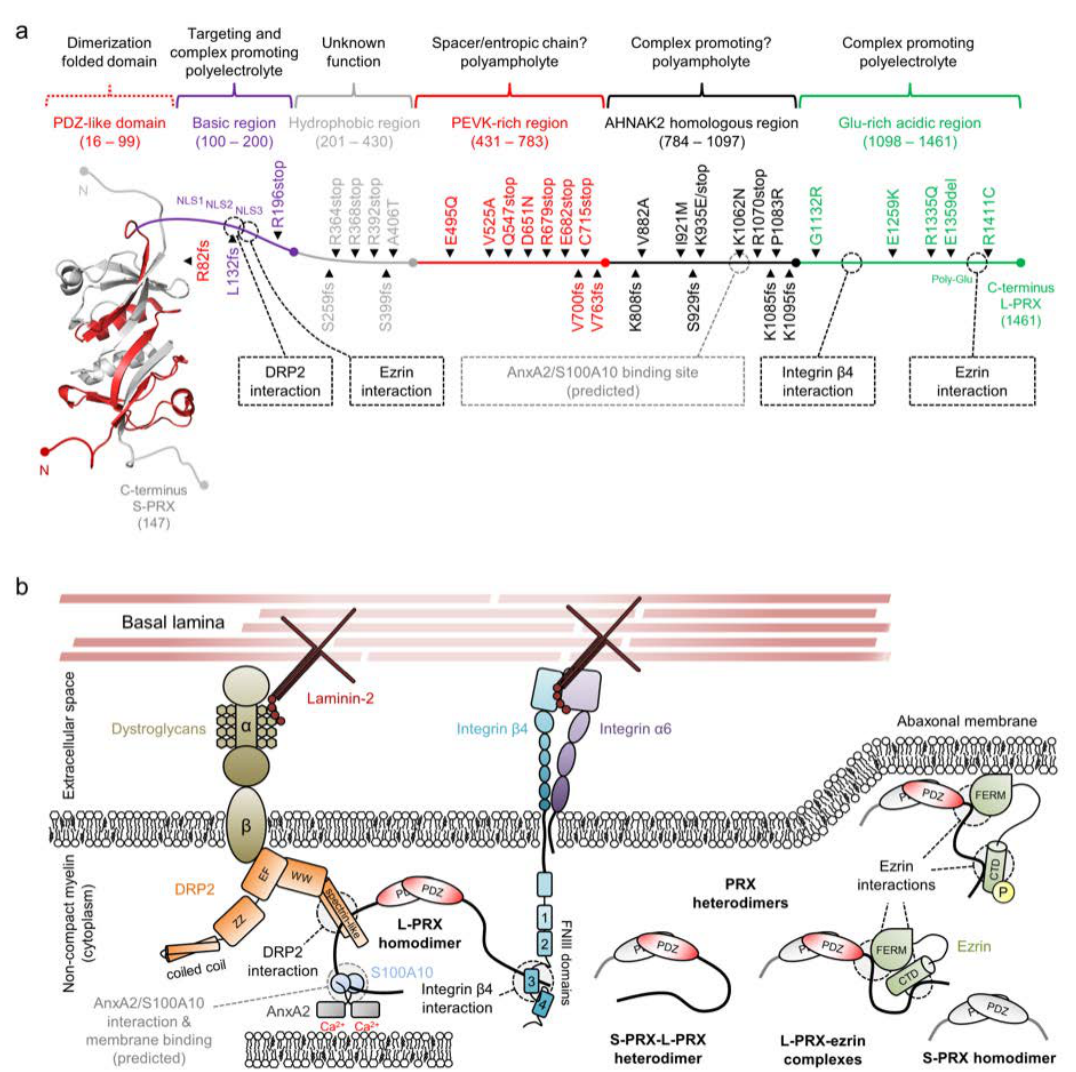
Figure 8. The structure and interactions of periaxin. ( a ) A schematic of a PRX heterodimer, with S-PRX in gray and L-PRX colored based on region, with the PDZ domain in red. L-PRX, apart from the PDZ-like domain, is predicted to be disordered [45], and can be divided into separate regions based on sequence composition. Peripheral neuropathy mutations are indicated alongside L-PRX. Dashed boxes and lines denote protein–protein interactions. L-PRX contains a predicted AnxA2 and S100A10 binding region, as reported earlier for AHNAK [195,196]. See Table 1 for mutation details. ( b ) L-PRX is an assembler within abaxonal non-compact myelin, linking dystroglycans and integrins together in membrane appositions, forming the periaxinosome. These interaction partners connect the Schwann cell basal lamina to the Schwann cell cytoplasm. S-PRX forms heterodimers with L-PRX, which might allow regulation of the cytoplasmic assembly as well as the nuclear export of L-PRX. Ezrin in complex with hetero- or homodimeric L-PRX might have relevance in such regulations, especially considering its phosphoregulated membrane-binding activity [197]. The function of the S-PRX homodimer is unknown. The significance of the putative L-PRX / AnxA2 / Sl00A10 ternary complex could involve linking the entire assembly via AnxA2 and Ca 2 + to the underlying membrane, possibly forming a structural basis for membrane appositions that line Cajal bands in myelinating Schwann